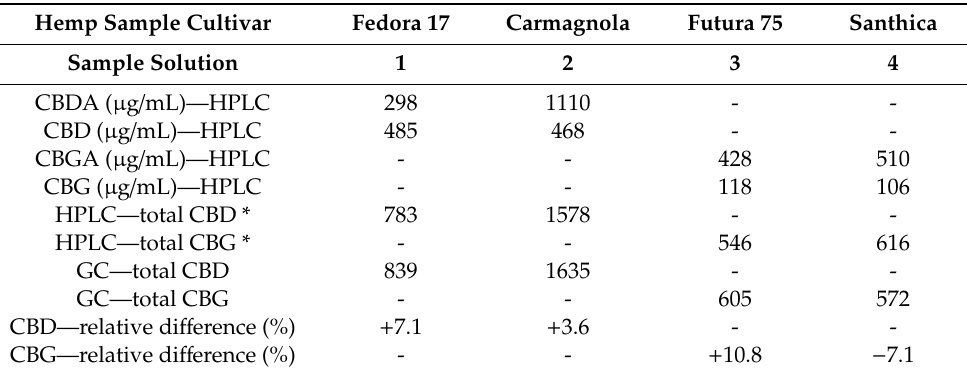
Table 2. GC and HPLC method